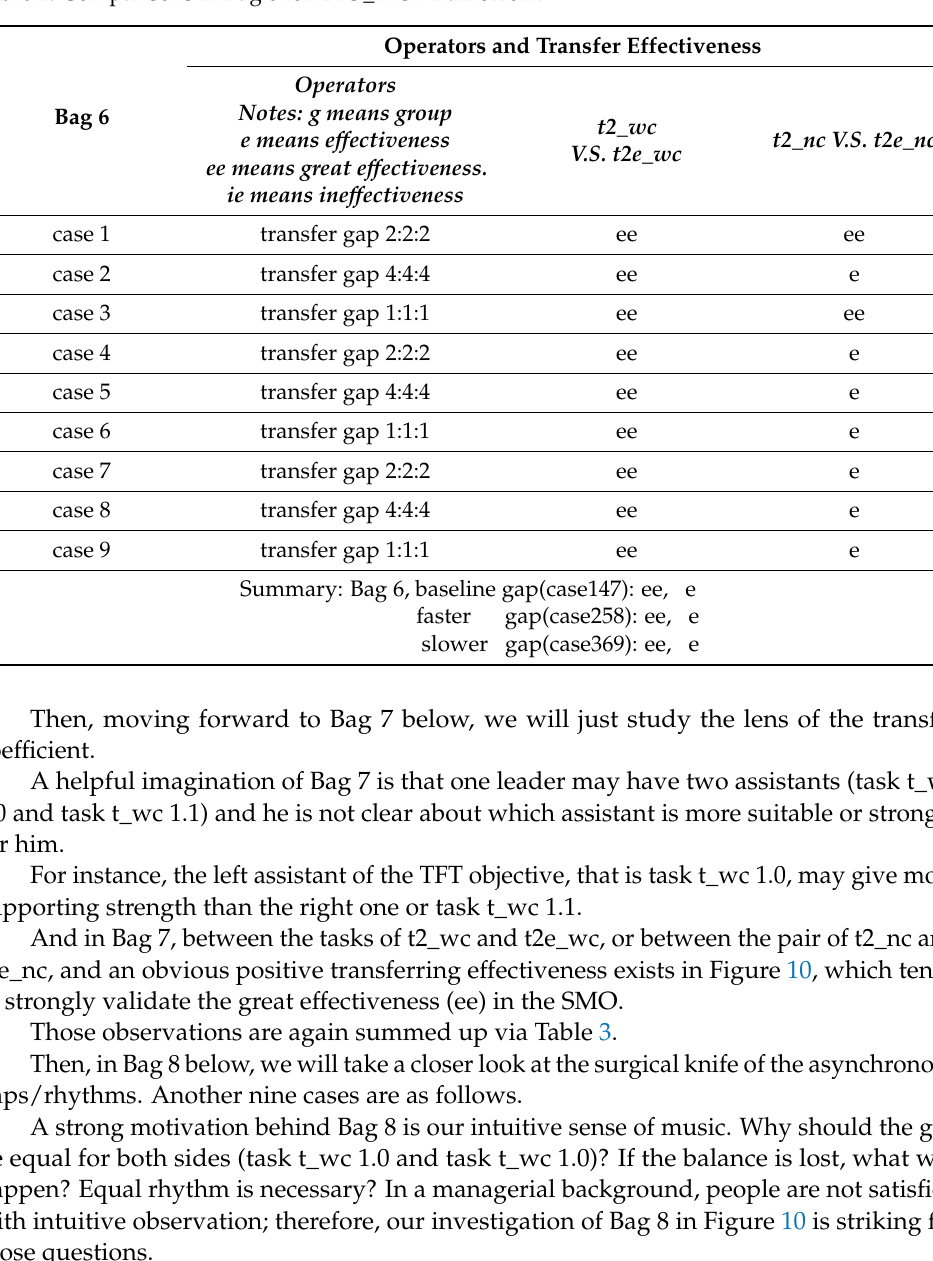
Table 2. Comparisons in Bag 6 for ETO_PFSP